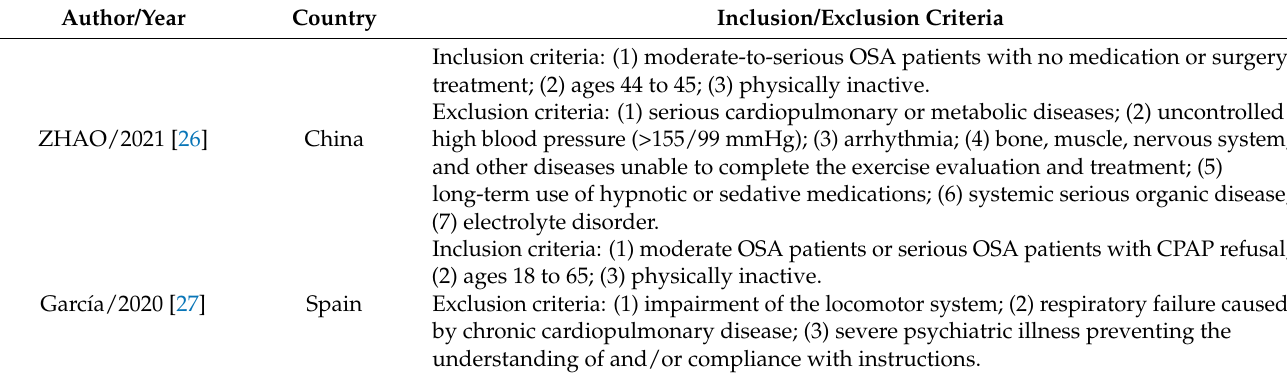
Table 2. Origin country and inclusion/exclusion criteria of